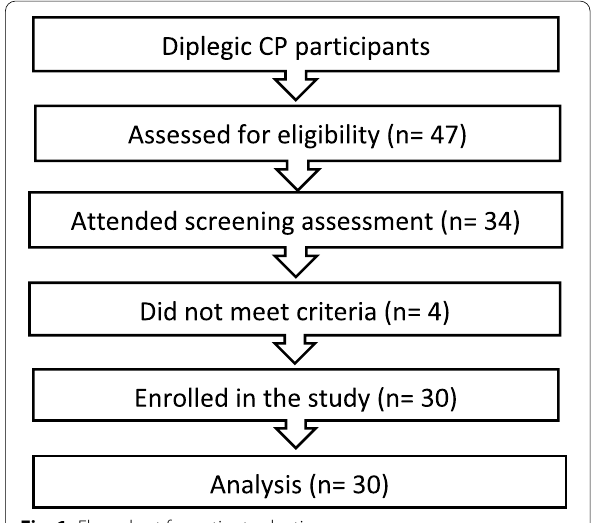
Fig. 1 Flow chart for patient